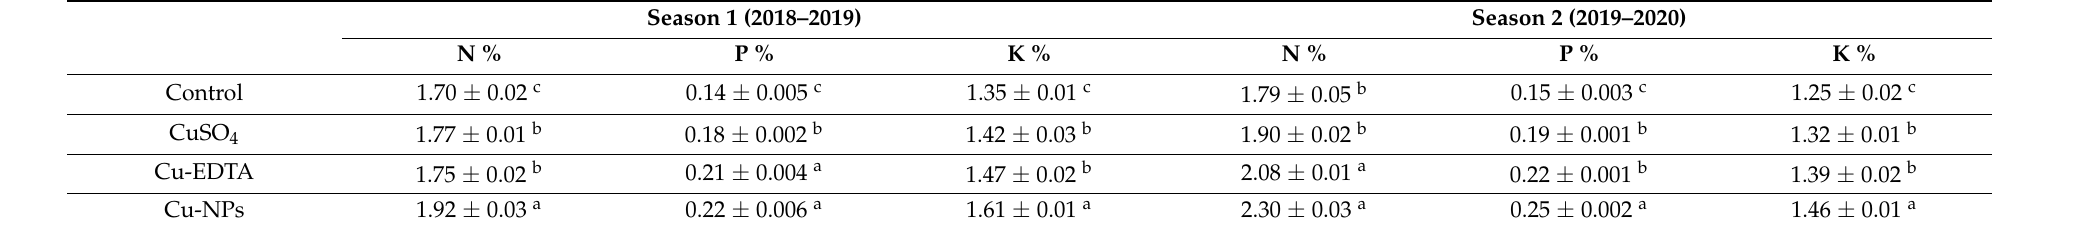
Table 6. Effects of different sources of Cu on N, P, and K % of onion in two seasons (2018/2019 and